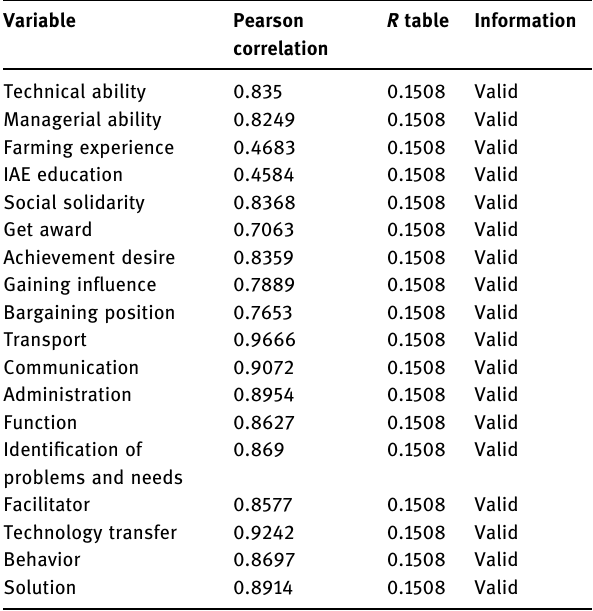
Table 3: The results of the validity test on the variable